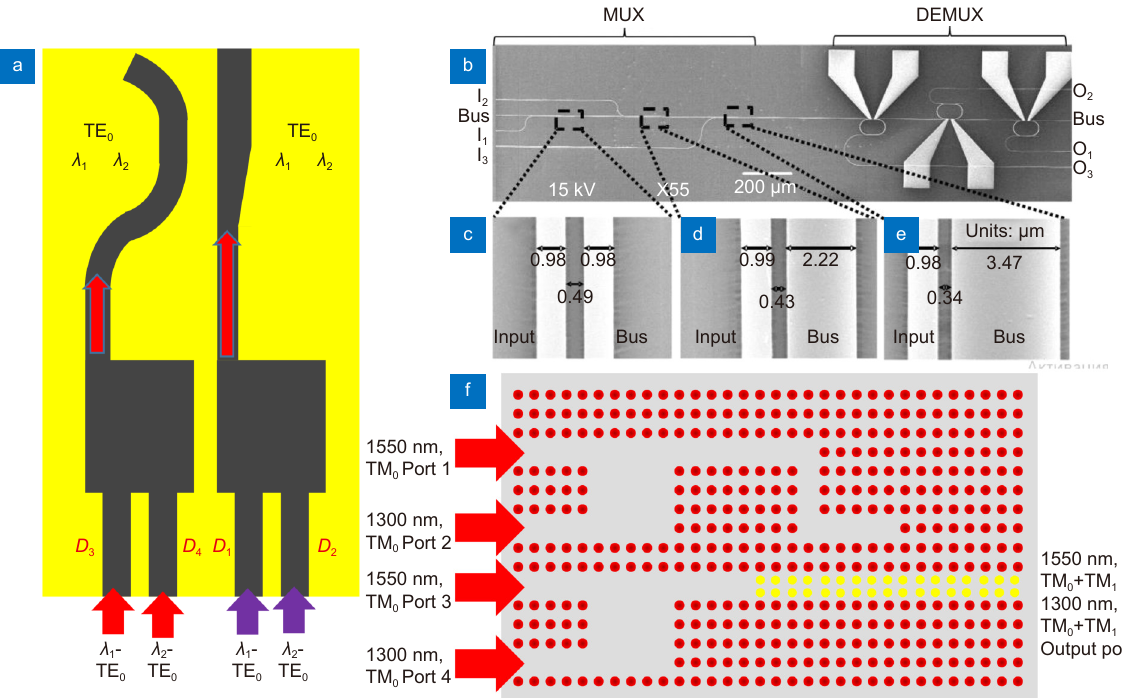
Fig. 15 | ( a ) Schematic representation of a silicon hybrid de (multiplexer) for MDM and WDM. ( b ) SEM image of the manufactured SiN hybrid MDM-WDM device. SEM pictures of the coupling regions between the input WGs and the bus WGs with a designed bus WG width of, ( c ) 1 μm, ( d ) 2.25 μm, ( e ) 3.5 μm. ( f ) Schematic representation of a hybrid WDM-MDM MUX/DEMUX. Figure reproduced from: (a) ref. 124 , (b–e) 125 ,